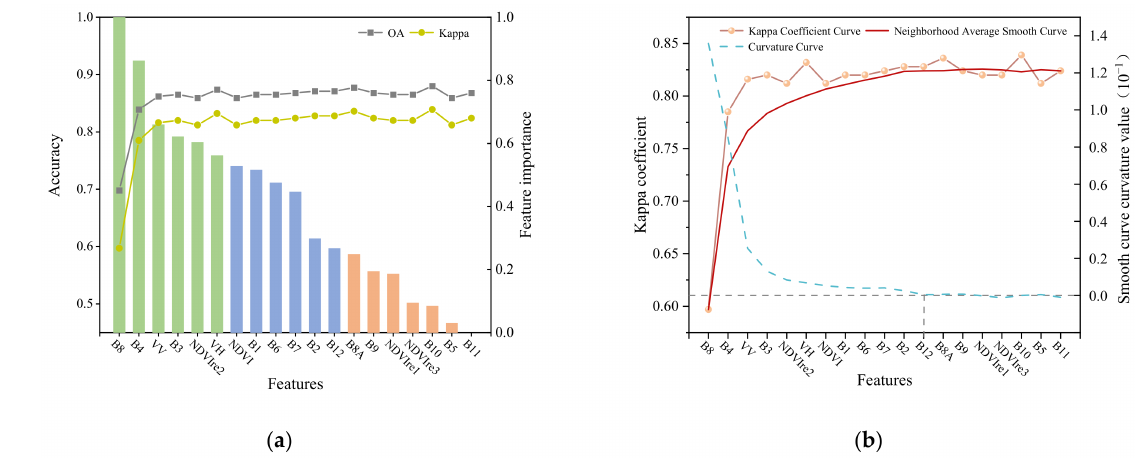
Figure 6. The relationship between features and classification accuracy and the graph of feature screening methods. ( a ) Variation of classification accuracy with features; ( b ) Determine feature threshold diagram.